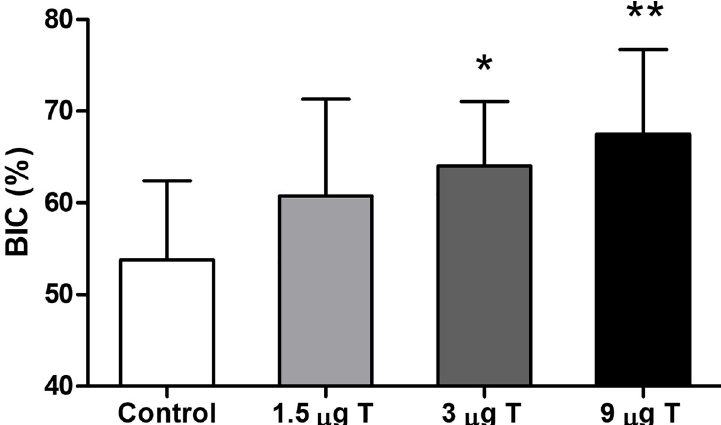
Fig 6. Bone implant contact (BIC) analysis of rabbit femoral condyle implantation model after 8 weeks. Coated screws (n = 7–10) showed a dose dependent increase in BIC, with significant increased BIC for screws coated with 3 and 9 μ g testosterone (T) and 2 μ g alendronate compared to controls. Significant differences compared to controls are indicated by asterisks: � p � 0.05 and �� p � 0.01. final sterilization using gamma irradiation (25 kGy). Application of various top layers of PLGA 5004A, not containing testosterone or alendronate, were essential to prevent a burst